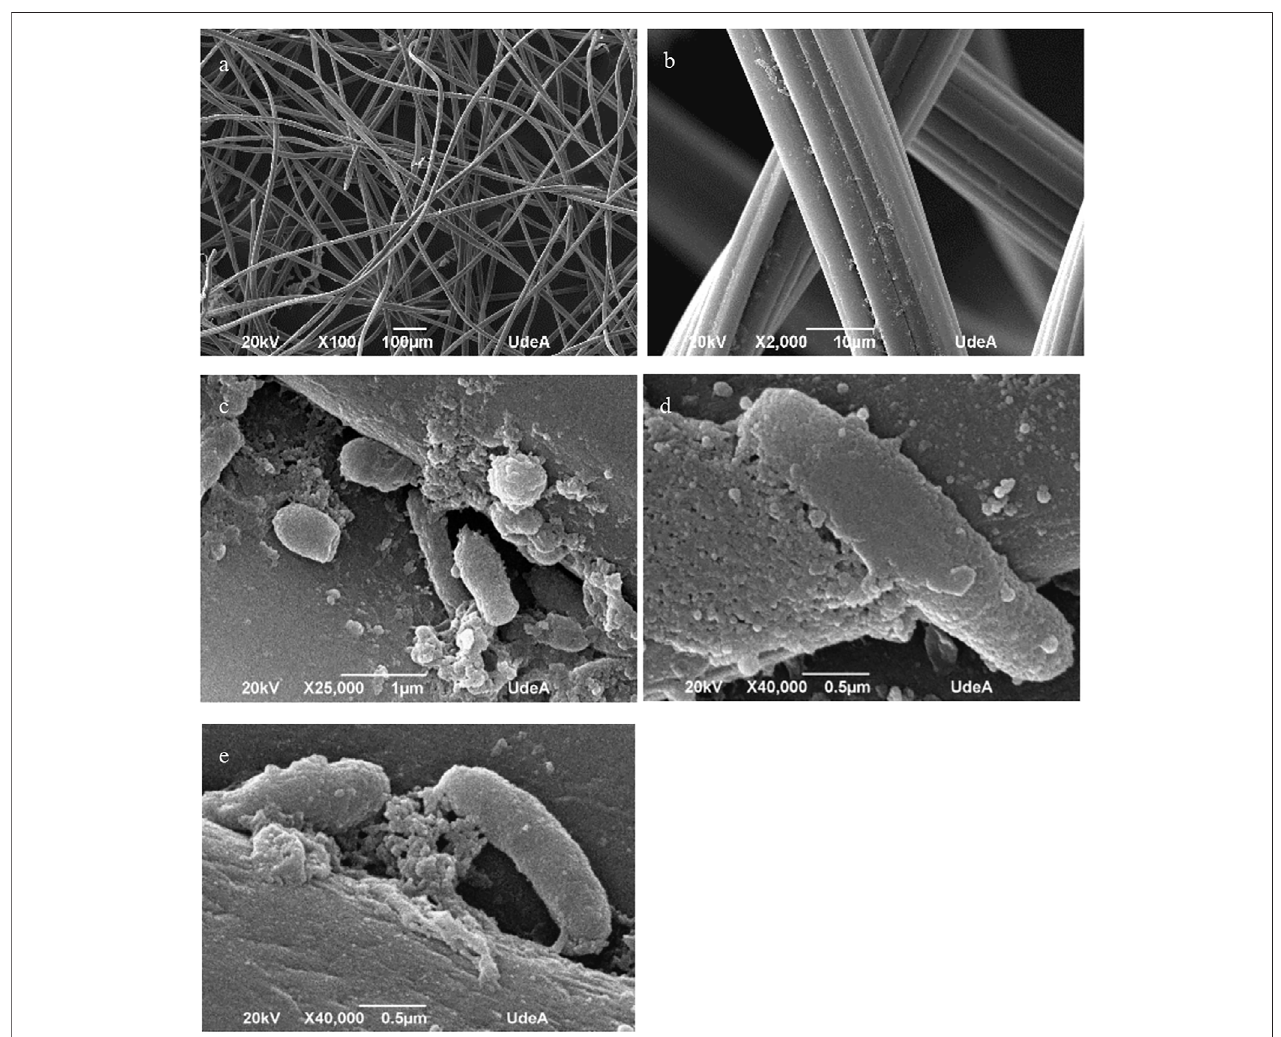
FIGURE 8 | Analysis by scanning electron microscopy of the anode of MFC1. The images show the microscopic changes observed in the carbon felt fi bres after operation for 37 days (A) X100 magni fi cation; (B) 2000X magni fi cation. (C) Microbial cells embedded in polymeric substance can be observed attached to the carbon fi bres; (D,E) . show details of the rough and irregular surface of the fi bres caused by the deposits of polymeric substances.